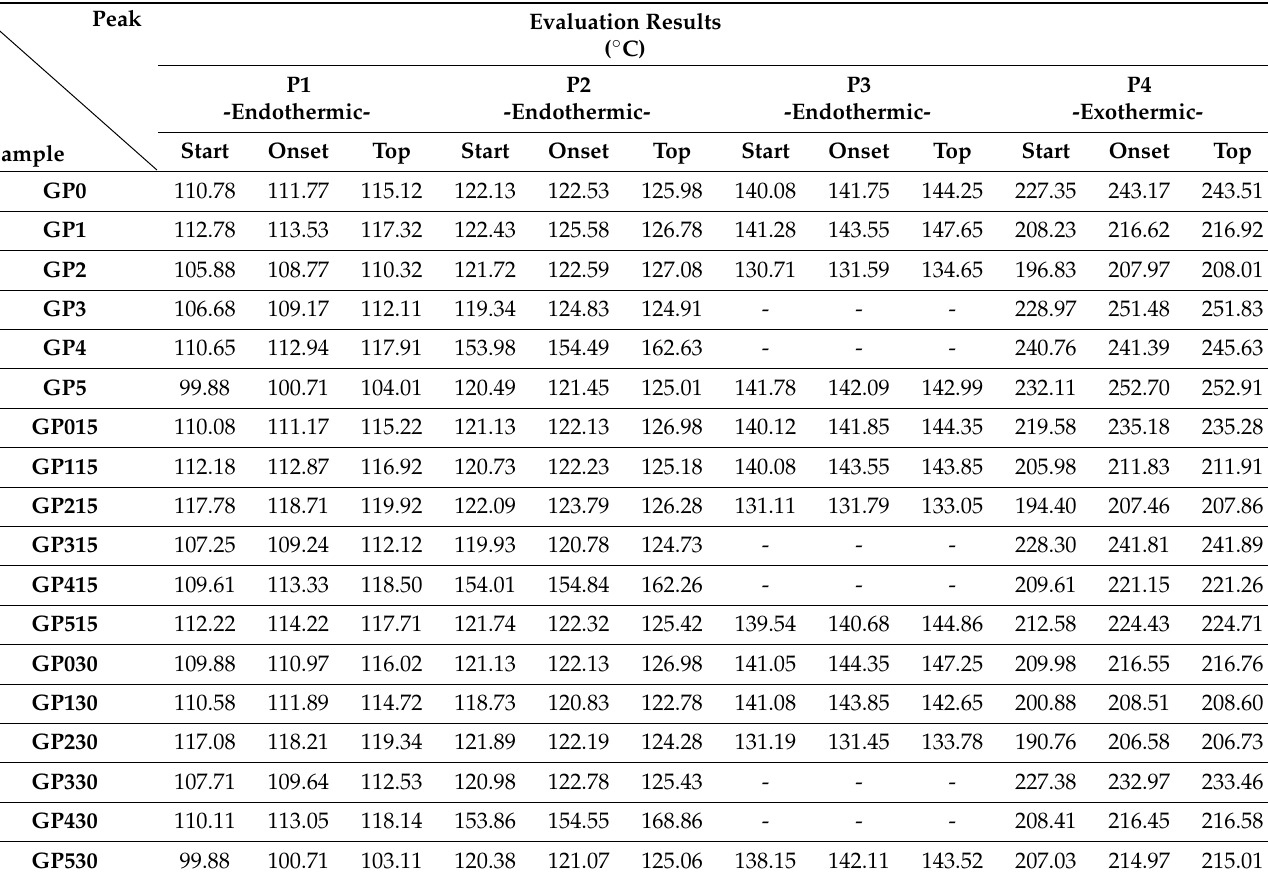
Table 7. Thermal characteristics of “green” considered fuel